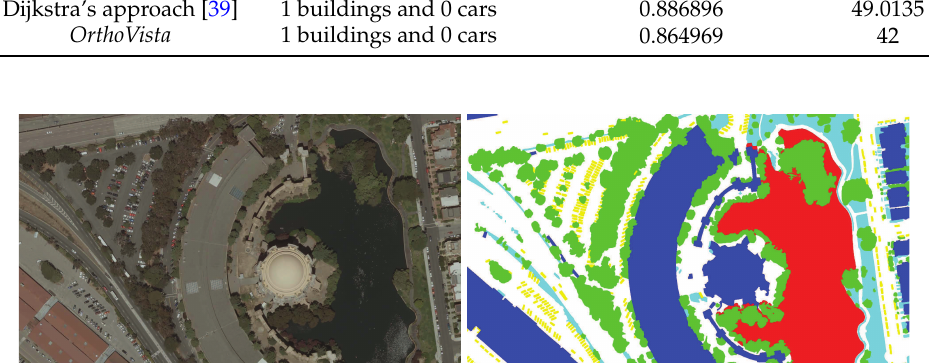
Figure 11. A demonstration of a small example image from the San Francisco dataset: ( left ) the original image; ( right ) the corresponding ground truth image classified as buildings (blue), cars (yellow), trees (green), low vegetation (cyan), water (red) and impervious surface